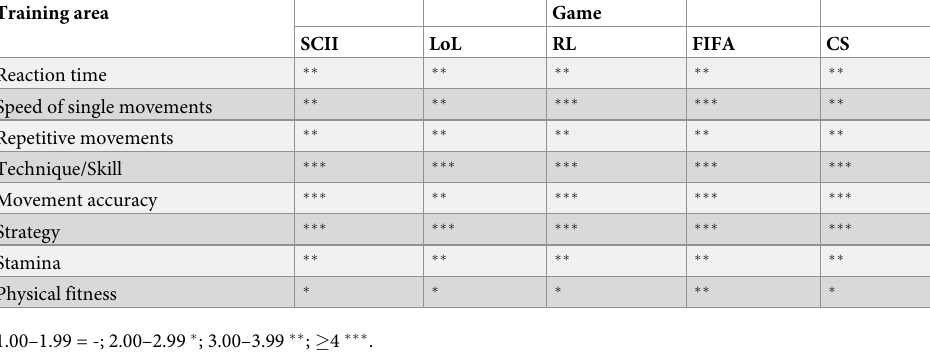
Table 28. Results regarding the differences between the esports in training area importance